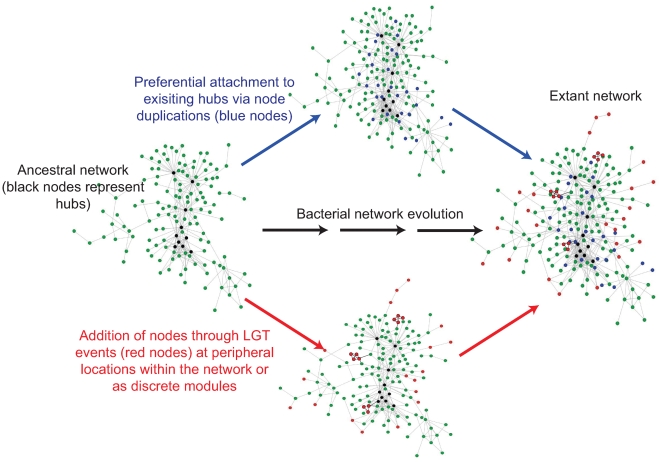
Amended model of the evolution of the E. coli interaction network.From an ancestral network, new interactions are acquired either through the duplication of existing genes (blue nodes) or the acquisition of novel genes through lateral gene transfer events (LGT – red nodes). The preferential attachment model suggests that duplicated genes are more likely to be located at the core of the network (genes associated with large gene families are more highly connected and more central to the network). On the other hand we find that LGT derived proteins tend to be more peripheral and/or integrated as a discrete module perhaps because they are less liable to disrupt essential functions associated with the network core.